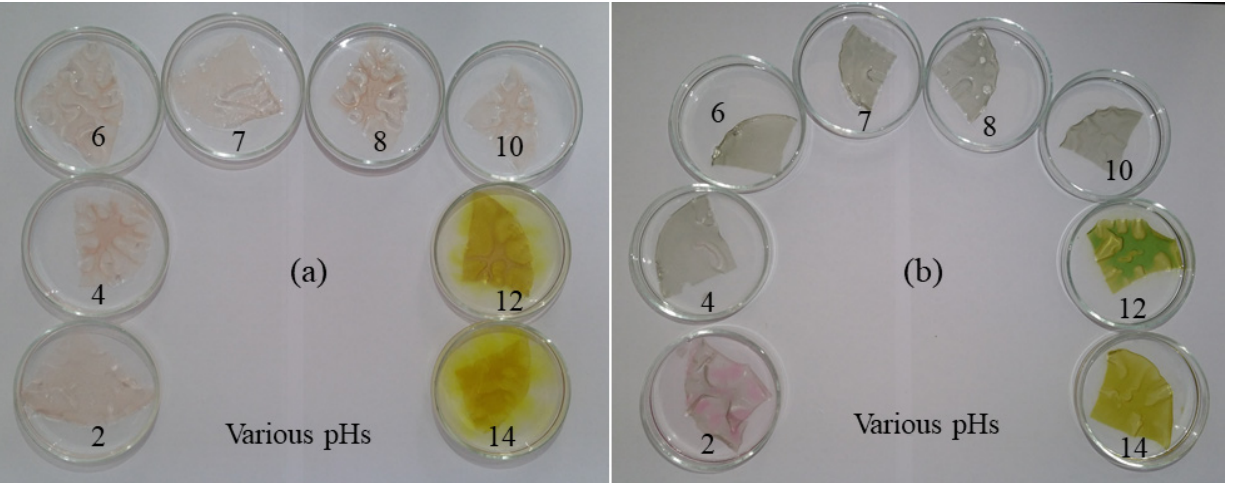
Figure 2. pH dependence of colorimetric indicators at various buffer solutions (pH = 2–14). ( a ) G/CsNFs/BAs; ( b ) G/CsNFs/SPAs.